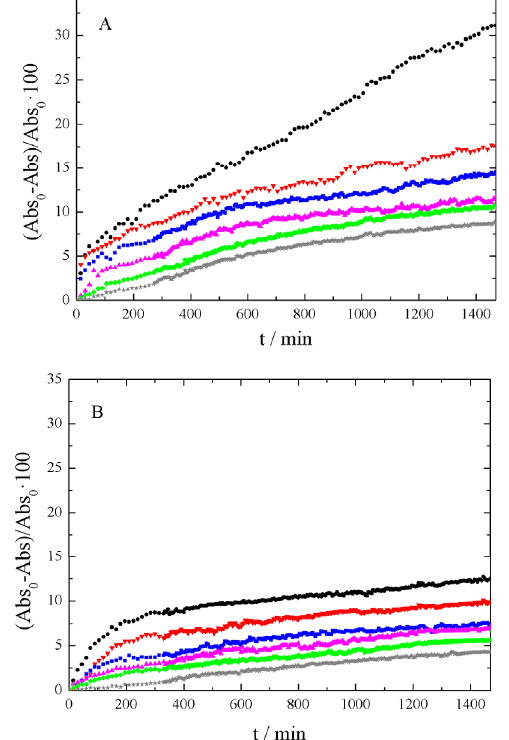
Figure 6. Cont Figure 6. Cont .